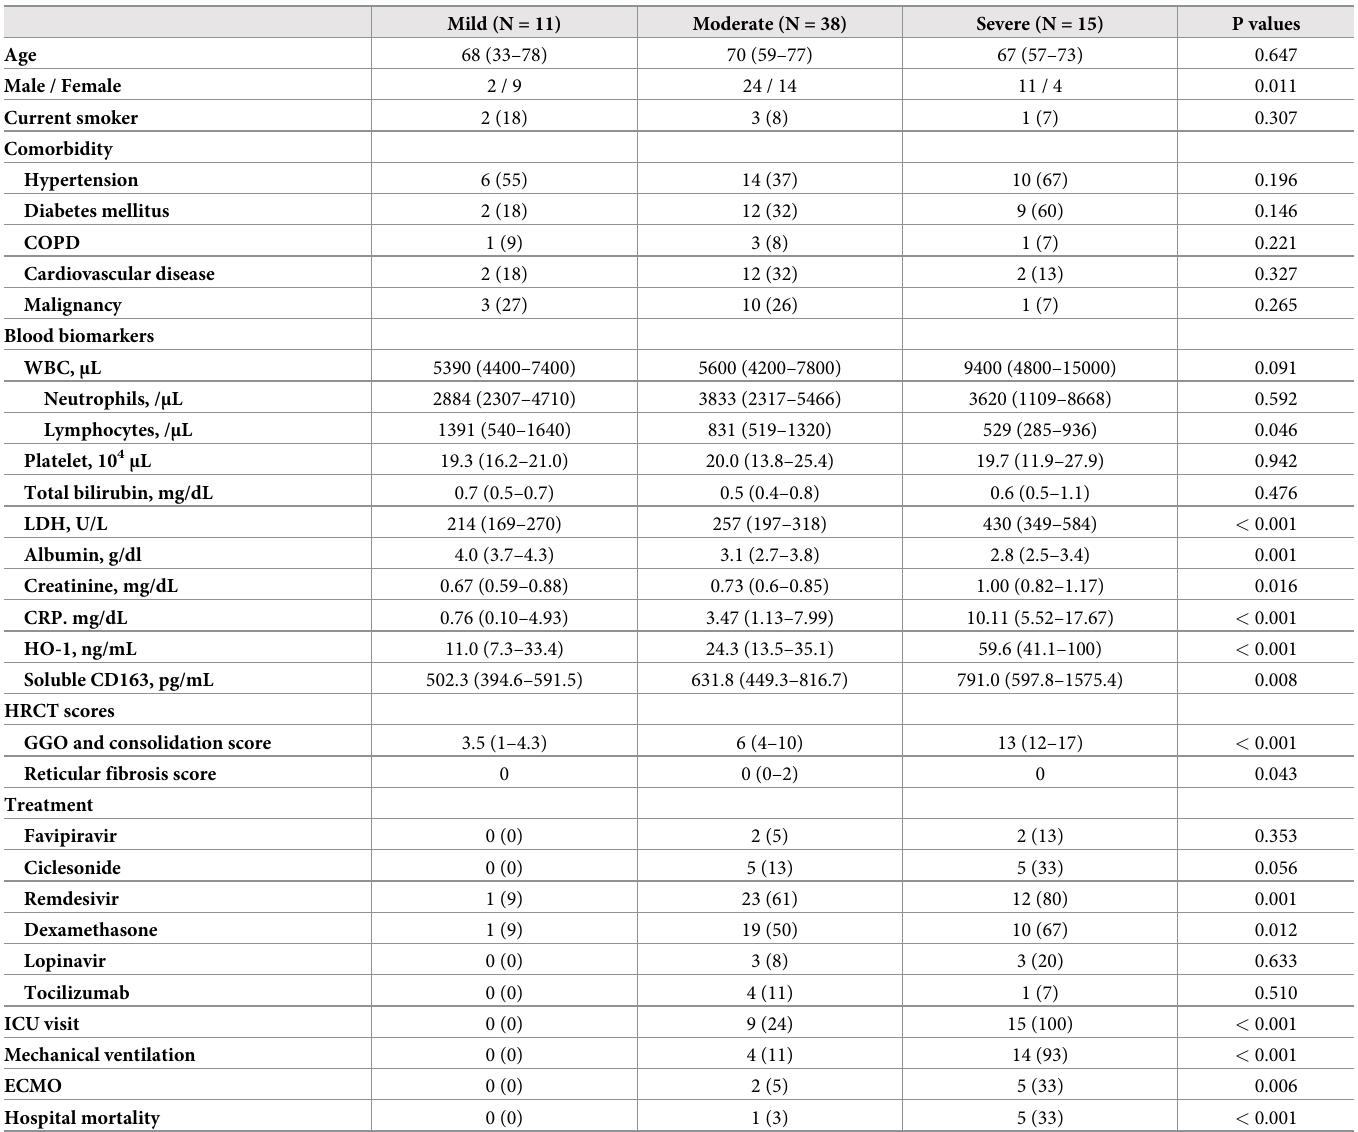
Table 1. Patients’